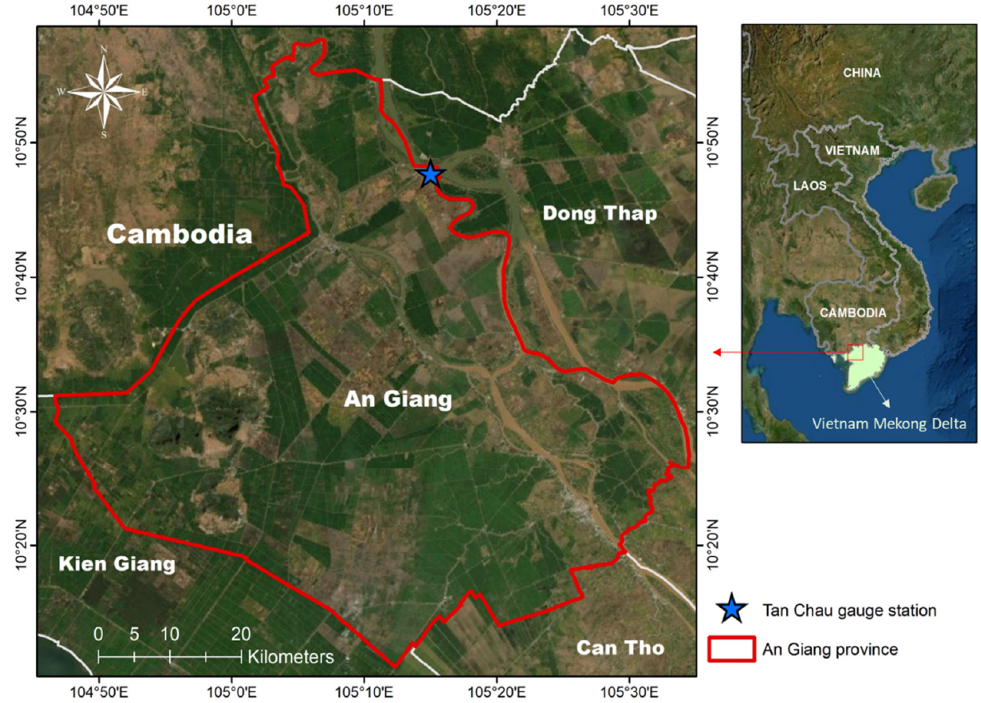
Figure 1. An Giang province with Tan Chau gauge station (10.79°N–105.24°E) in the Vietnamese Mekong Delta.